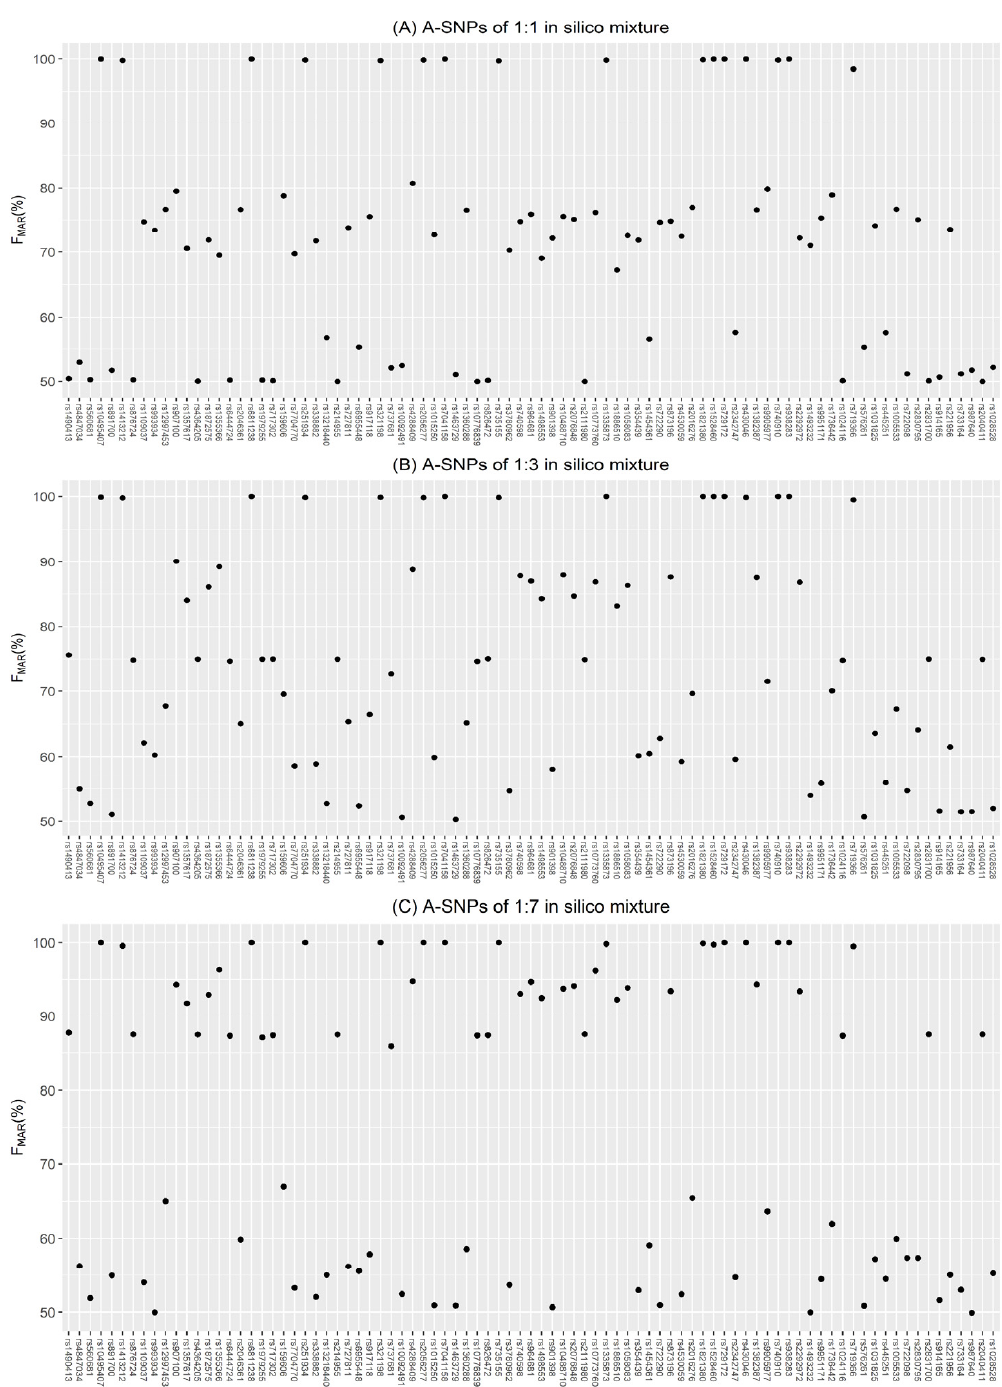
Figure 2. Examples of F MAR values for three in silico mixtures. ( A ) The points were mainly concen- trated in three regions: the first cluster was close to 100% of the y-axis, the second cluster was between 70% and 80%, and the third cluster was between 50% and 60%. ( B ) The points were scattered in the range of 50% to 100% with no obvious clustering trend. ( C ) There were almost no points between 70% and 80%, and the points were clustered above 80% and below 70%, which could be considered as clustering into two categories.